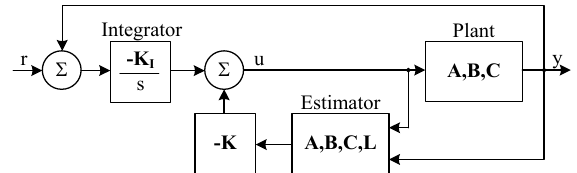
Figure 8: Block diagram of the state feedback con- troller. A state estimator is necessary for generating the full state vector including ro- tor acceleration, which is not measurable. Naturally, an integral action is added to re- move the steady-state error.